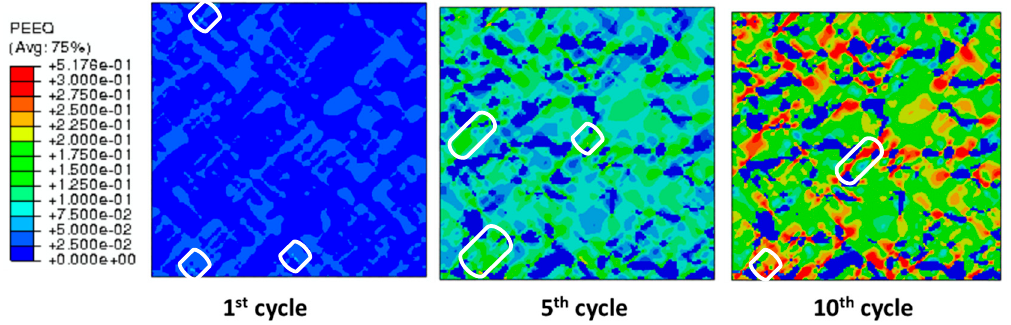
Figure 7. Equivalent plastic strain distribution at maximum aggregate stress with a different number of cycles.